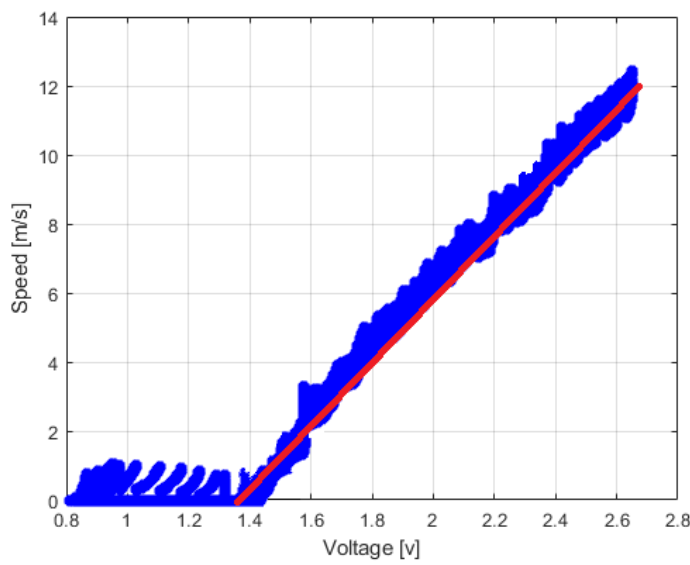
Figure 7. Accelerator vs. motor speed voltage